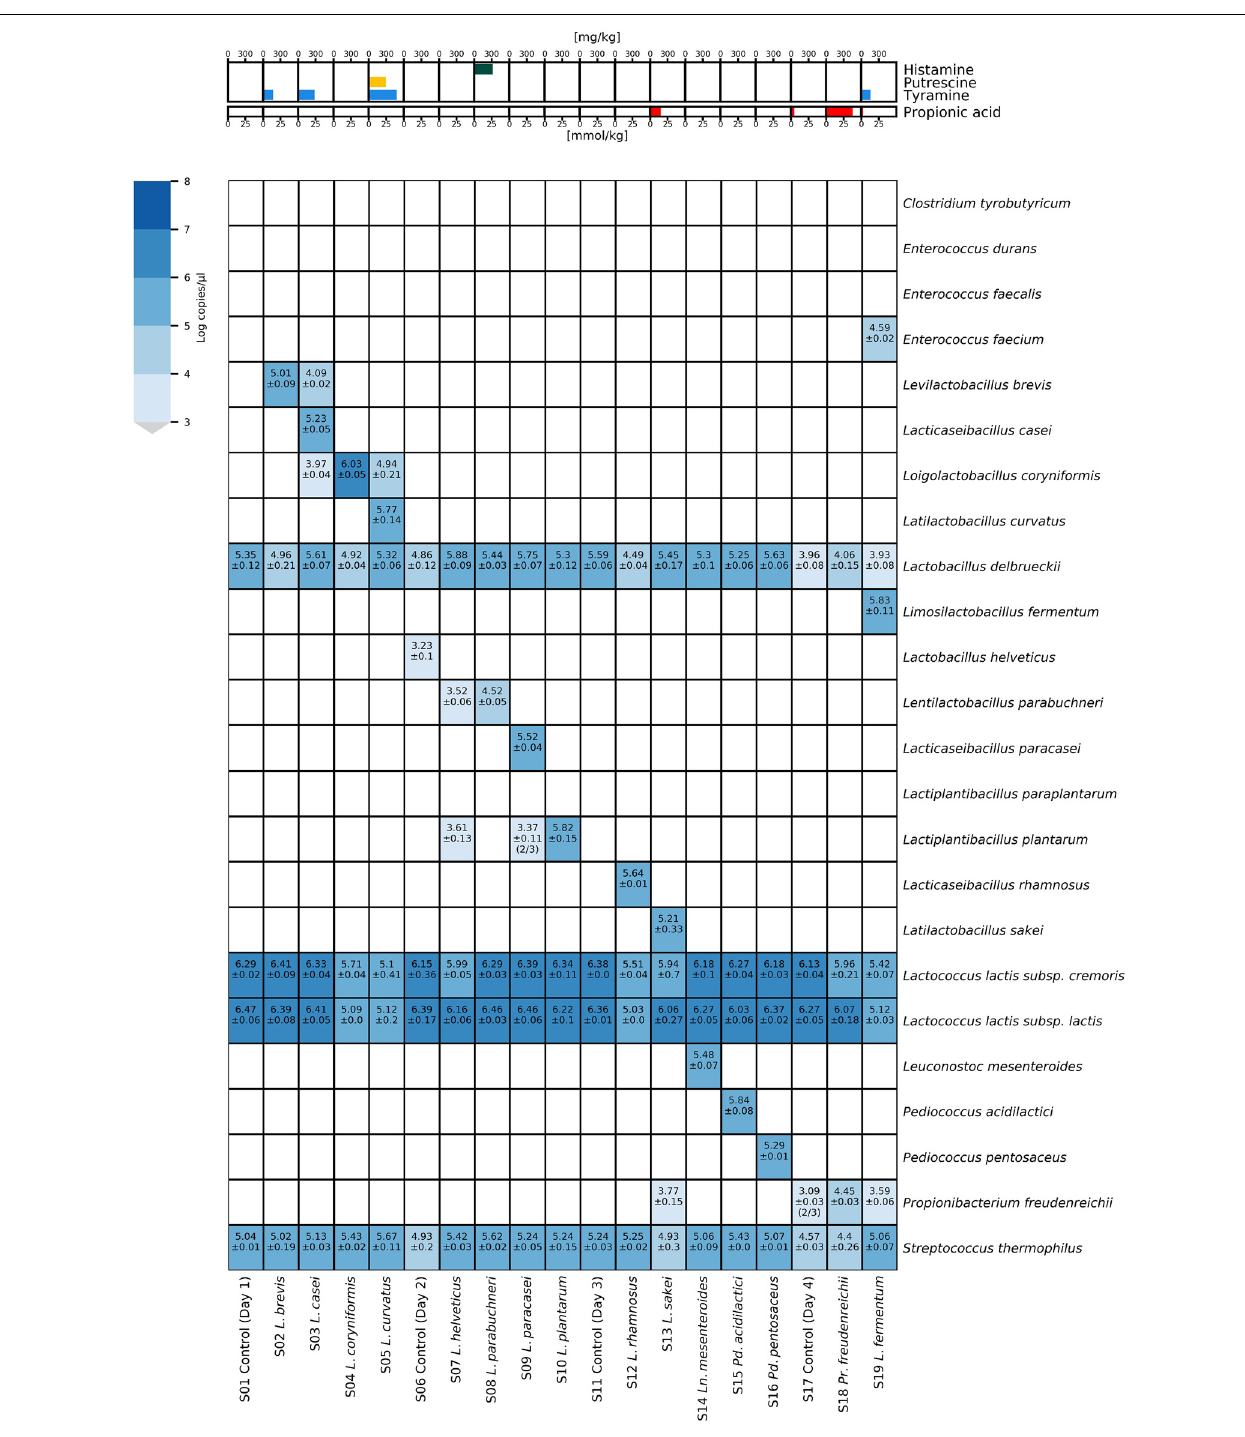
sensory perception. The results obtained from the HT-qPCR analysis of the mock community dilutions indicate that all assays are able to quantify a minimal population density of 10 6 genome